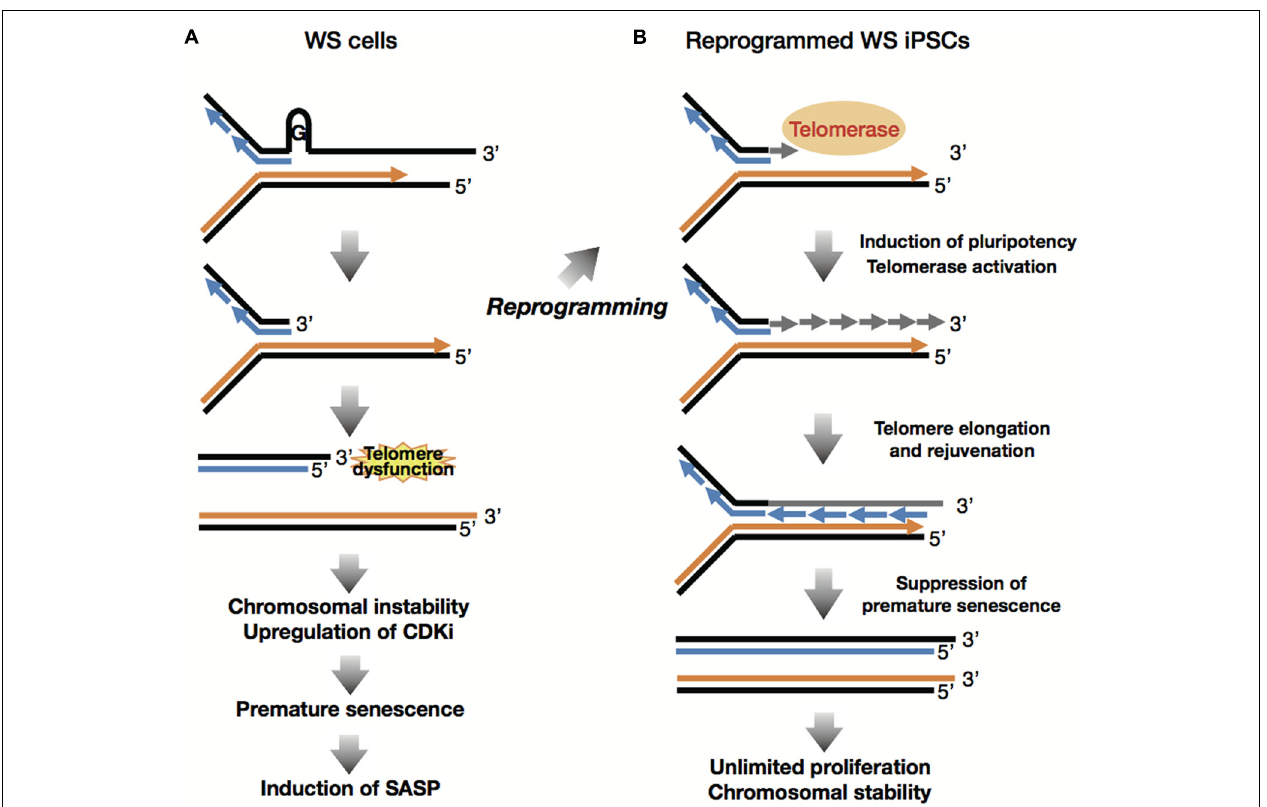
Reprogramming involves induction of pluripotency and global epigenetic alteration toward ESC-like state, which suppress senescence phenotypes including CDKi and SASP. Reprogramming also overcomes the lack ofWRN through activation of telomerase, consequently inducing telomere elongation and cellular